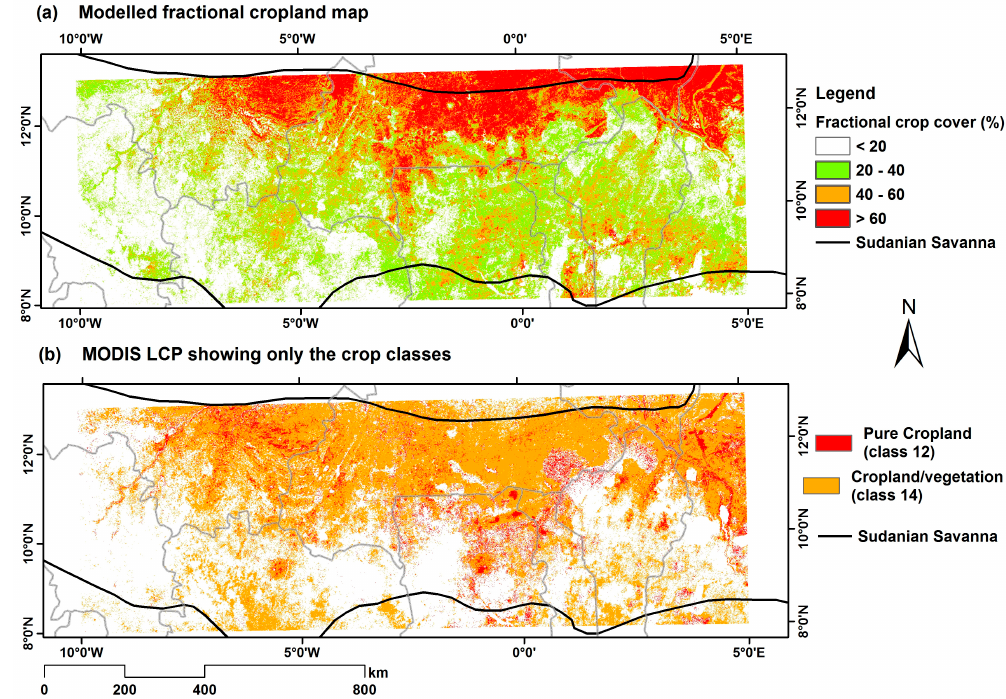
Figure 9. Spatial distribution of cropland in the Sudannian Savanna zone: ( a ) MODIS_FCM (cover fractions approach); and ( b ) MODIS_LCP (crop classes only).